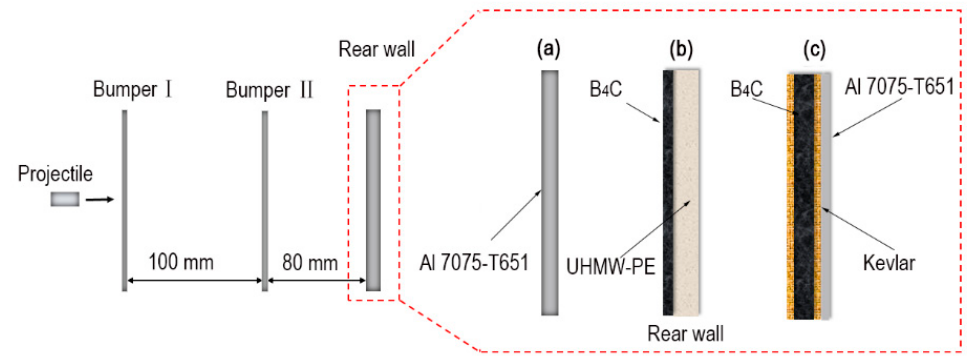
Figure 1. A sketch of the shield configurations.